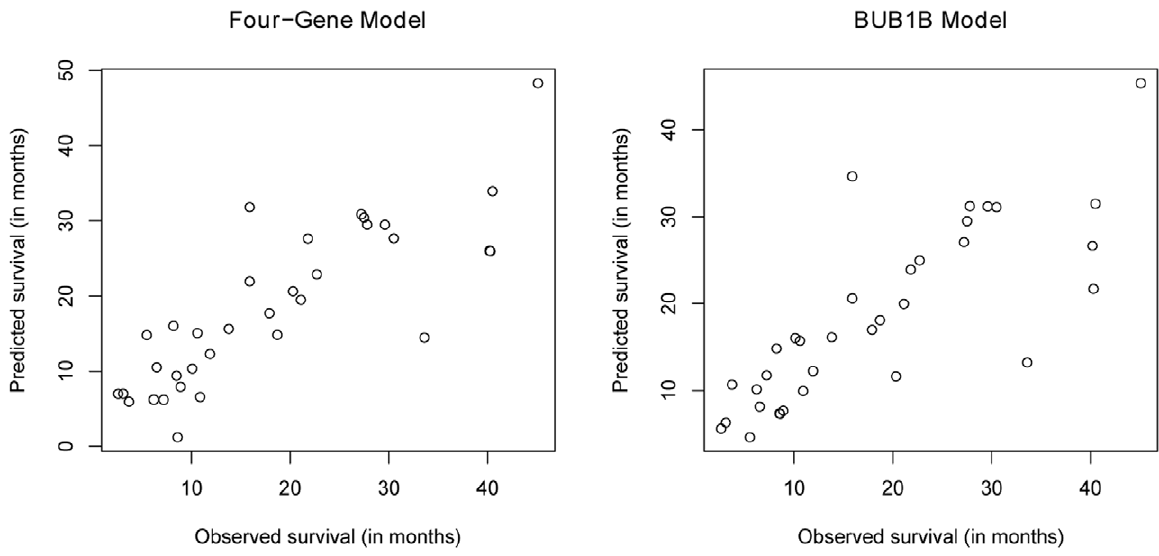
Figure 2. Scatter plots of observed and predicted survival times using leave-one-out cross-validation on 34 deceased glioma patients.